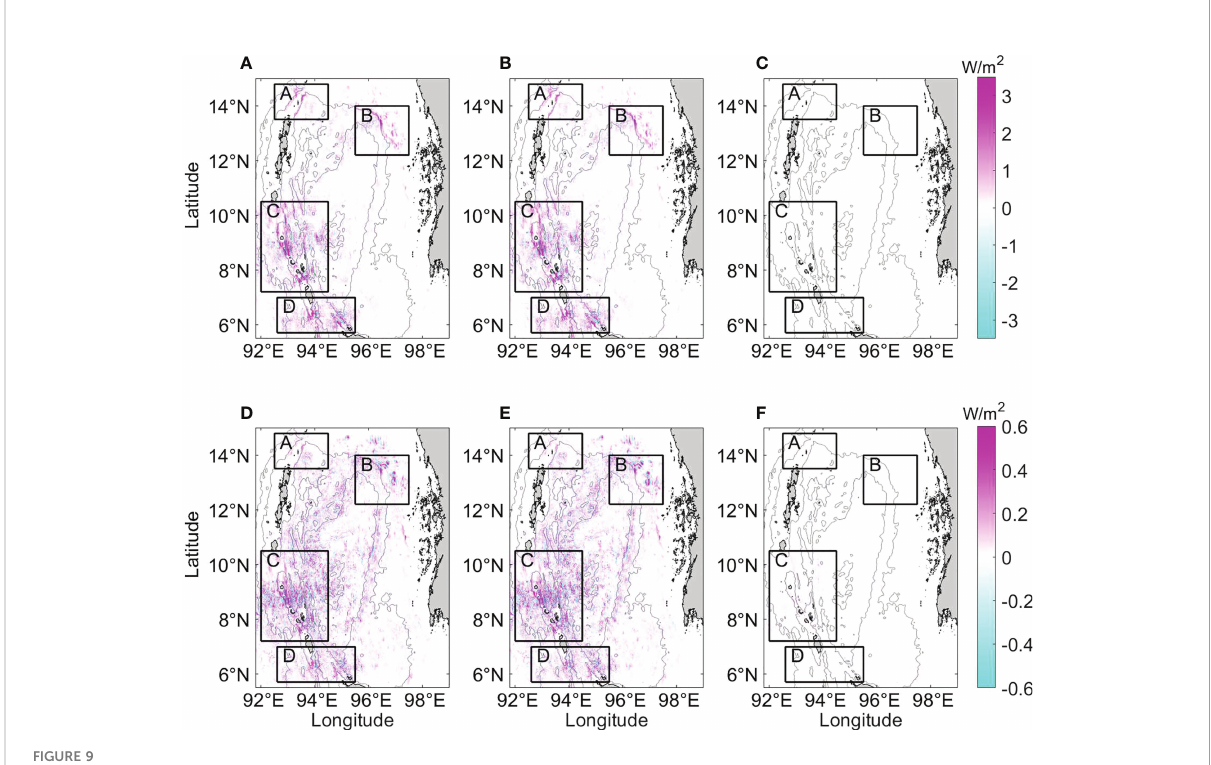
FIGURE 9 Spatial distributions of the time-averaged depth-integrated barotropic-to-baroclinic conversion rate in the (A, D) Experiment 1, (B, E) Experiment 2, and (C, F) Experiment 3. The period of (A ∼ C) is spring tide, and the range of color scale is − 3.5 ∼ 3.5 W/m 2 ; the period of (D ∼ F) is neap tide, and the range of color scale is − 0.6 ∼ 0.6 W/m 2 . The four rectangles present the main generation subdomains of internal tides. Bathymetry contours are spaced at 500 and 2000